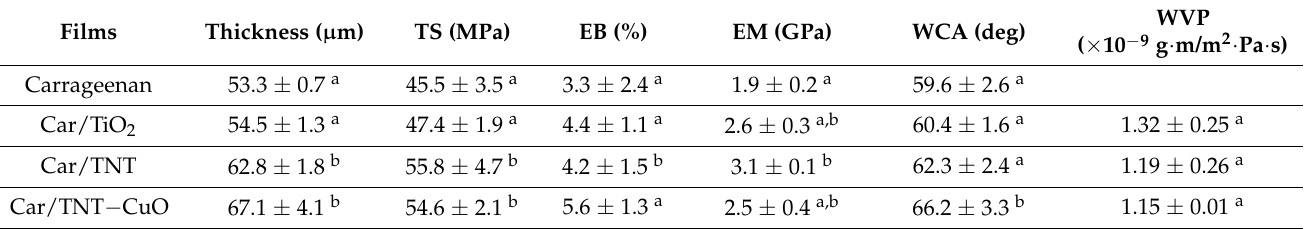
Table 9. Mechanical and water interactive properties of the carrageenan composites with TiO 2 , TNT, and CuO (taken from [42] with permission from American Chemical